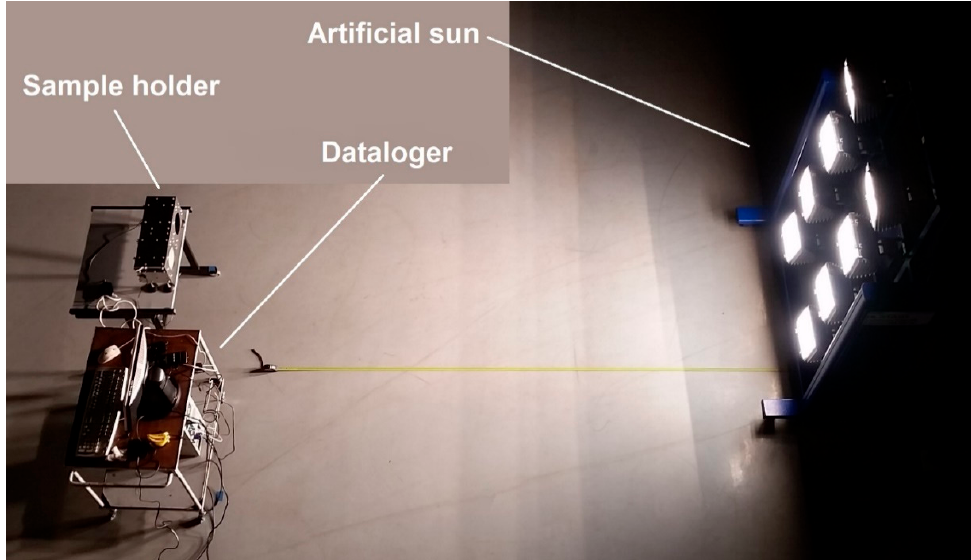
Figure 1. The general configuration of experimental set-up for direct transmittance measurements.